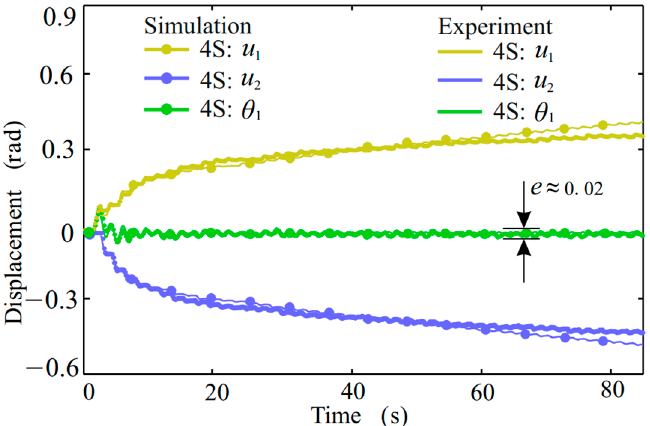
Figure 17. Serial-stiffness-switch system with improved semi-active vibration control strategy subject to from harmonic disturbance, here (cid:98) M d = 0.05 Nm, η s = 100 and η d = 3 and PID coefficients K p = 1.03 , K i = 0 and K d = 1. Solid bold line: experiment results; point-solid line: simulation; yellow: deformation of spring 1, u 1 ; blue: deformation of spring 2, u 2 ; green: position of primary plate, θ 1